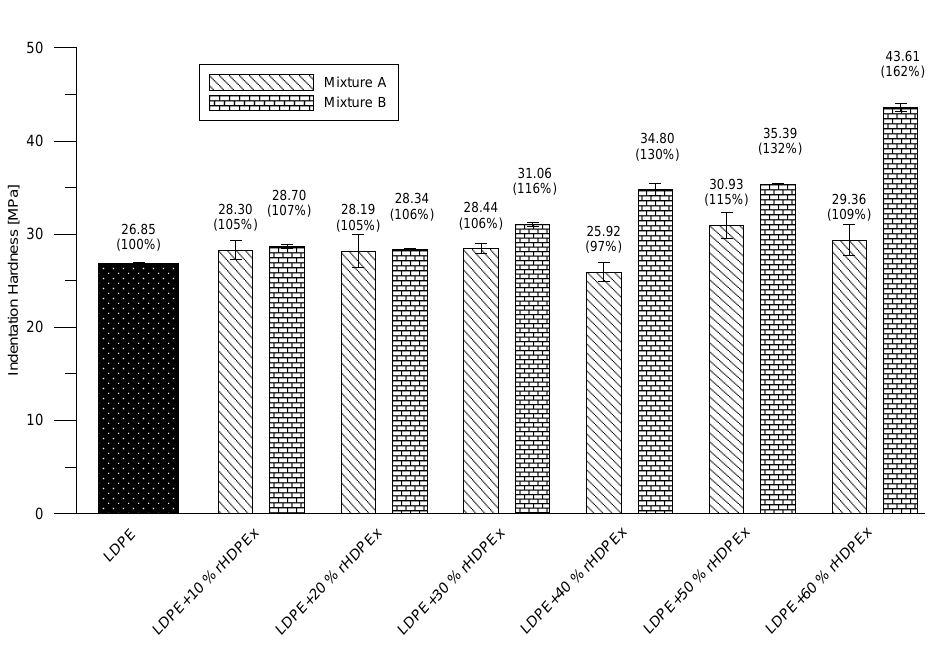
Figure 10. Shore D hardness—Mixtures A and B.